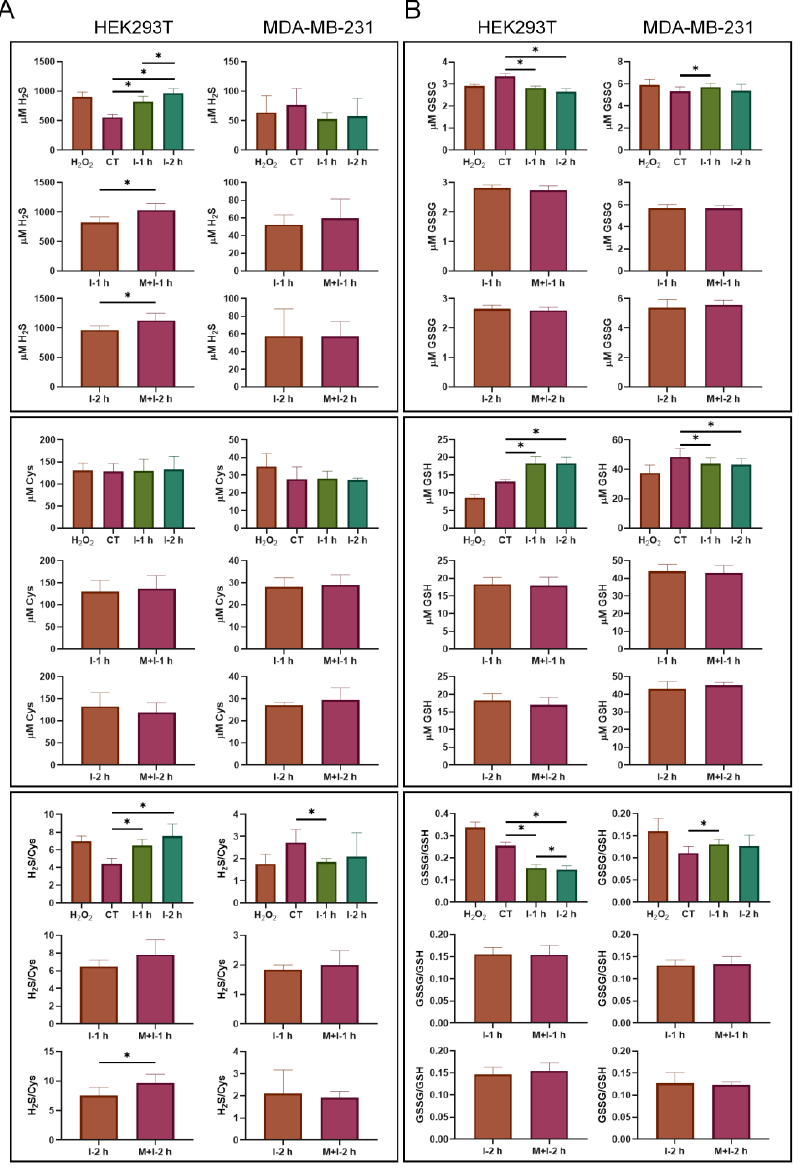
Figure 5. The change in cellular H 2 S, cysteine, GSSG and GSH in insulin or combined insulin and metformin-treated HEK293T and MDA-MB-231 cells. ( A ) The levels and ratio of cellular H 2 S and cysteine. The concentrations ( µ M in cells) were determined by the detected derivatives of H 2 S and cysteine with LC-MS. ( B ) The levels and ratio of cellular GSSG and GSH. The concentrations ( µ M in cells) were determined by the detected GSSG and derivatives of GSH with LC-MS. H 2 O 2 : 0.5 mM H 2 O 2 ; CT: control; I: 10 ng/mL insulin; M + I: 10 mM metformin (15 mM metformin for MDA-MB-231 cells) + 10 ng/mL insulin. The results with significant difference at p < 0.05 are indicated by *. ( n =